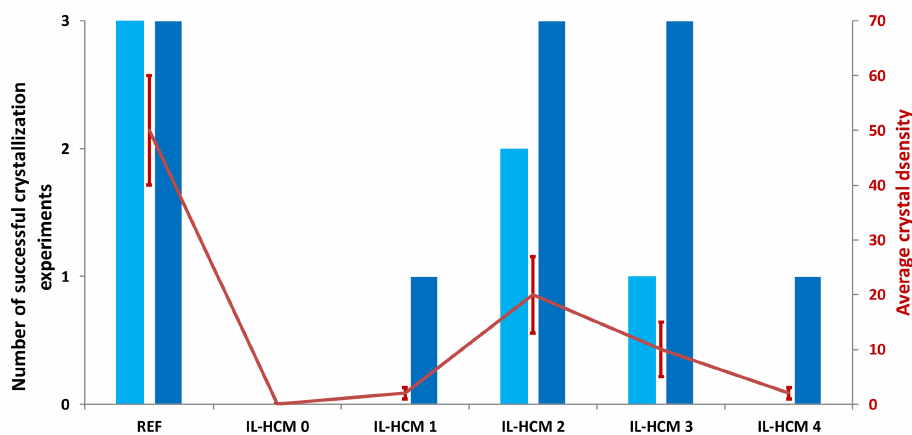
Figure 1. Number of successful crystallization experiments, proportional to nucleation probability (bars, left vertical axis) and average crystal density (line, fight vertical axis) related to the glucose isomerase crystallization performed on 4 di ff erent ionic-liquid hydrogel composite membrane (IL-HCM) supports (IL-HCM 1-4). REF is related to the crystallization performed by using the standard sitting drop setup and IL-HCM 0 is related to the test with bare hydrophobic membrane. Nucleation probability is the fraction of wells producing crystals and average crystal density is the mean of crystals for each well, both with respect the three replicates performed for each support. Error bars in the average crystal density indicate estimated measurement errors, while bar heights indicate the minimum (light blue) and maximum (dark blue) number of successful crystallization experiment, as determined by considering uncertainties in the visualization of crystals.